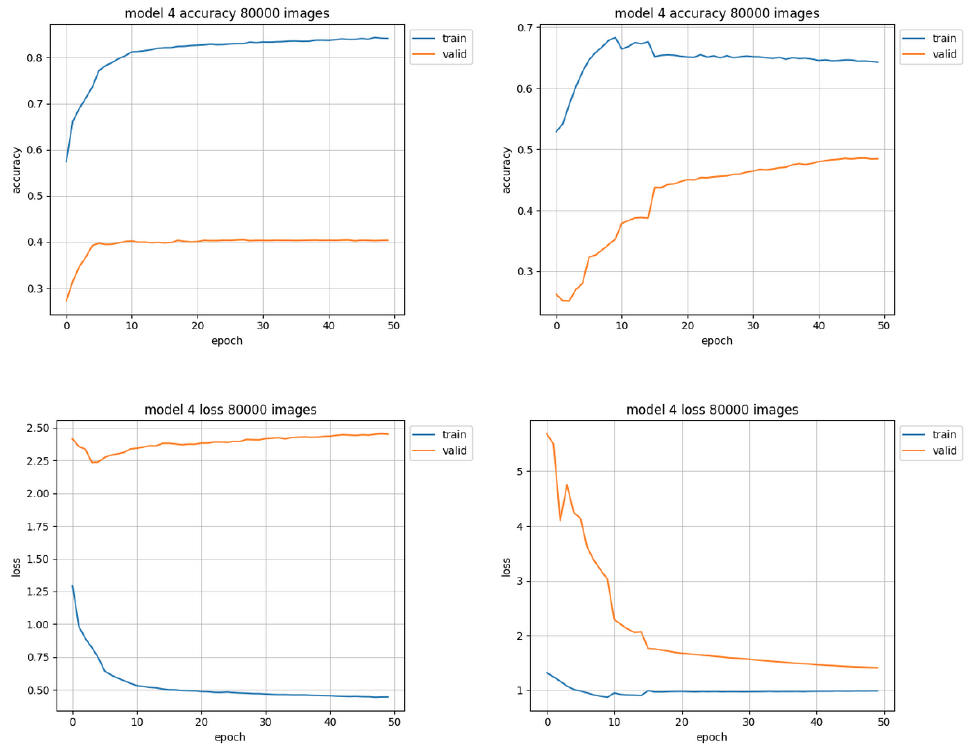
Figure 11. Training results using 80,000 images. Charts on the left side of figure present results using unleveled data distribution, charts on the right side show results using leveled data distribution.